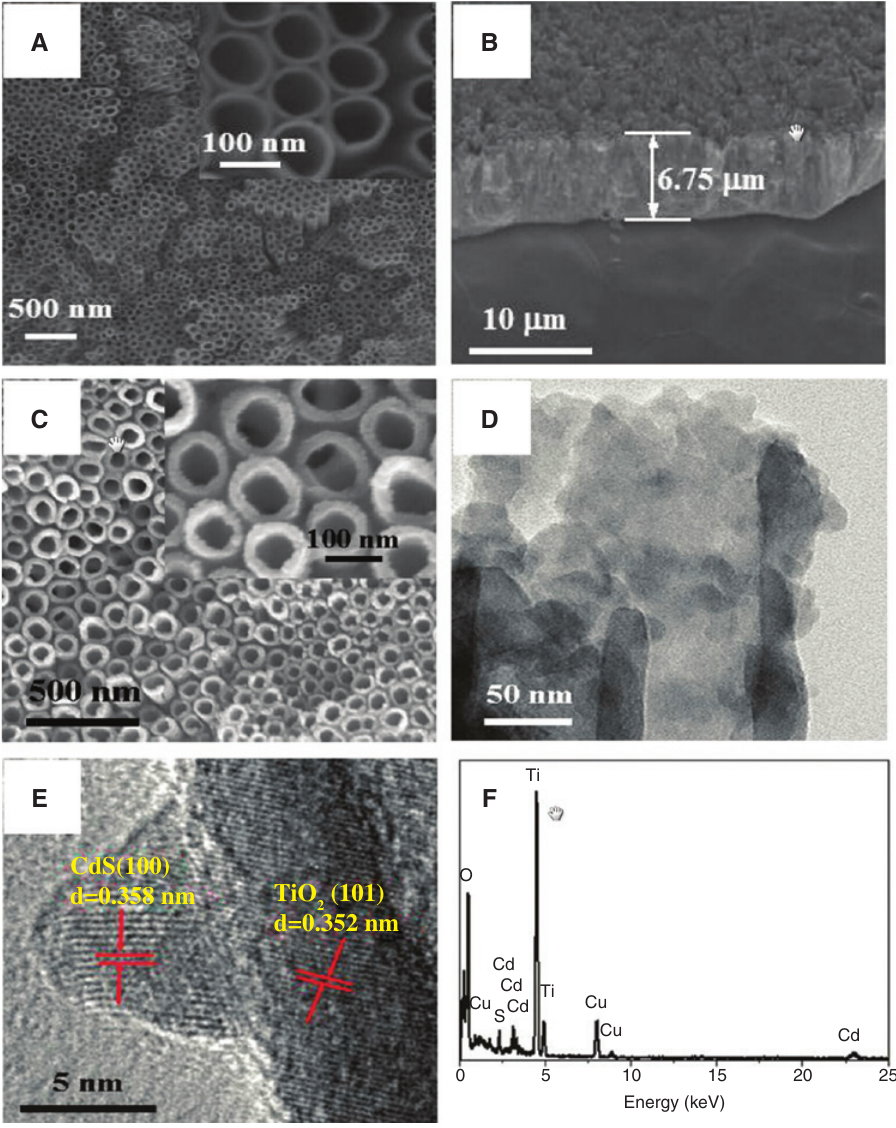
NTAs. SEM image (C) of CdS QDs/TiO 2 NTAs fitted to the TEM. Reproduced from Ref. [175] with permission. Copyright American 2